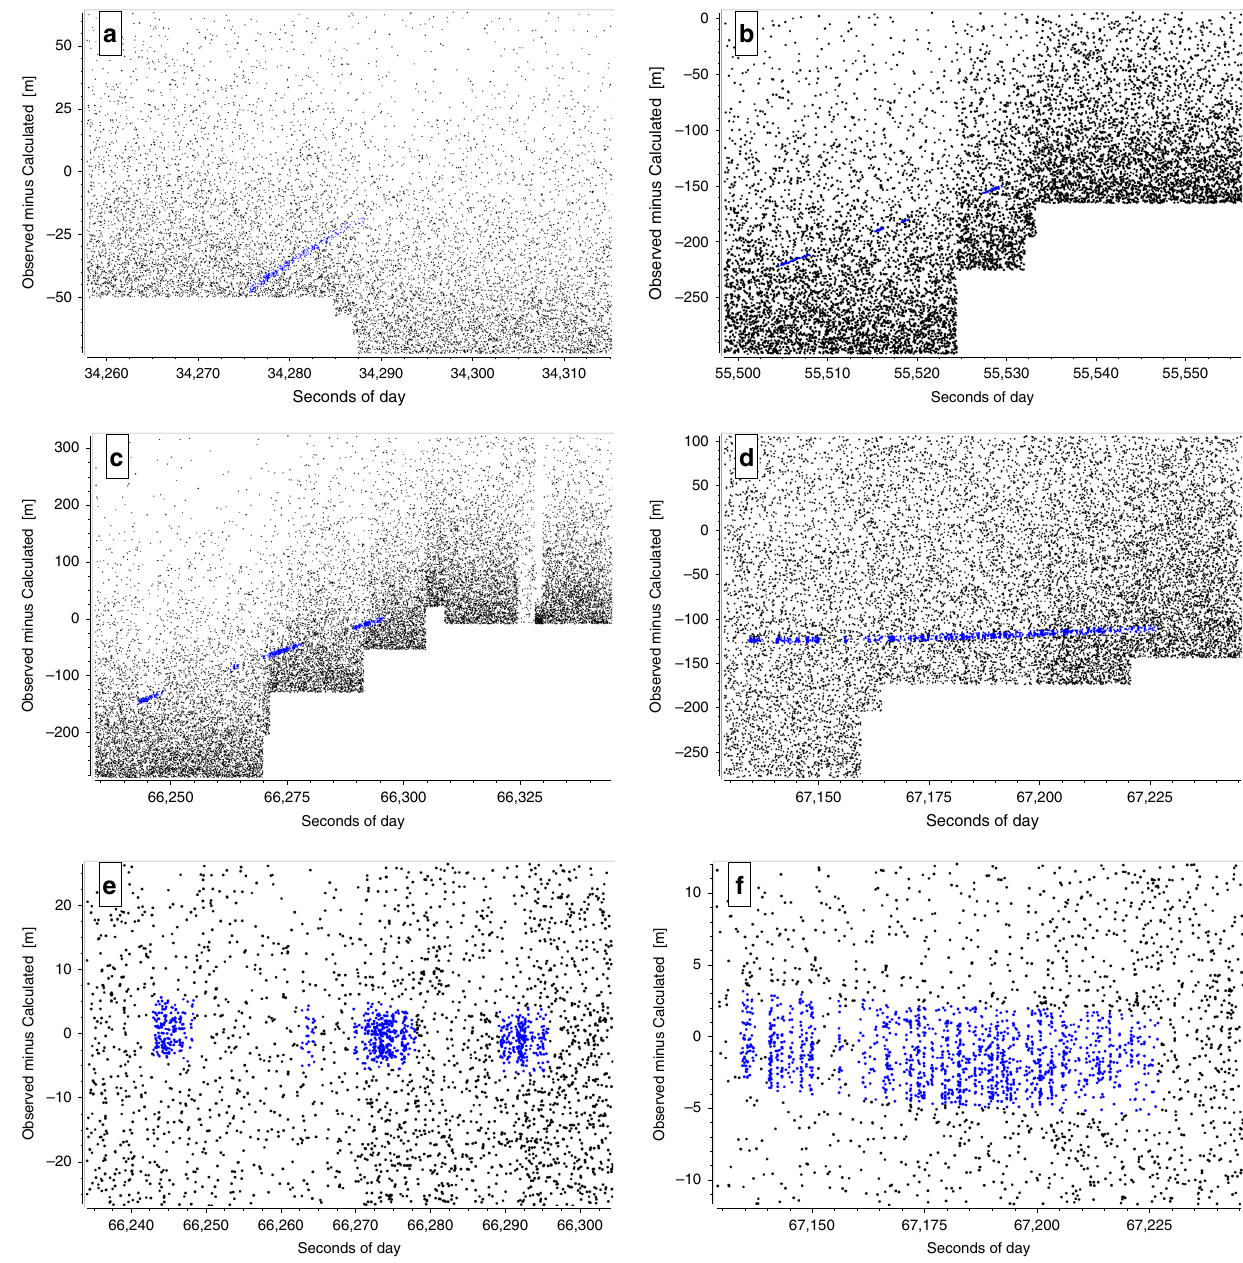
Fig. 1 Daylight space debris laser ranging results. Observed-minus-calculated residuals [m] of four successful daylight space debris laser ranging passes to rocket bodies at different sun elevations (el sun ). For a – d time biases (tb) are applied during post-processing as set during the observations. For e , f , time biases (tb) and range biases (rb) are corrected during post-processing to match the measurements to the orbit predictions. Identi fi ed returns during post- processing are highlighted in blue color. a SL-16 R/B (#22285), tb = 9 ms, 2019/03/22, 10:31 (el sun = 39.2°), b SL-14 R/B (#20511), tb = − 76 ms, 2019/ 07/24, 20:24 (el sun = 2.0°), c SL-16 R/B (#23705), tb = 140 ms, 2019/07/24, 20:38 (el sun = 0.2°), d SL-16 R/B (#22803), tb = − 150 ms, 2019/10/01, 17:25 (el sun = 11.5°), e close up of ( c ), tb = 200 ms, rb = 415 m, f close up of ( d ), tb = − 158 ms, rb = 133